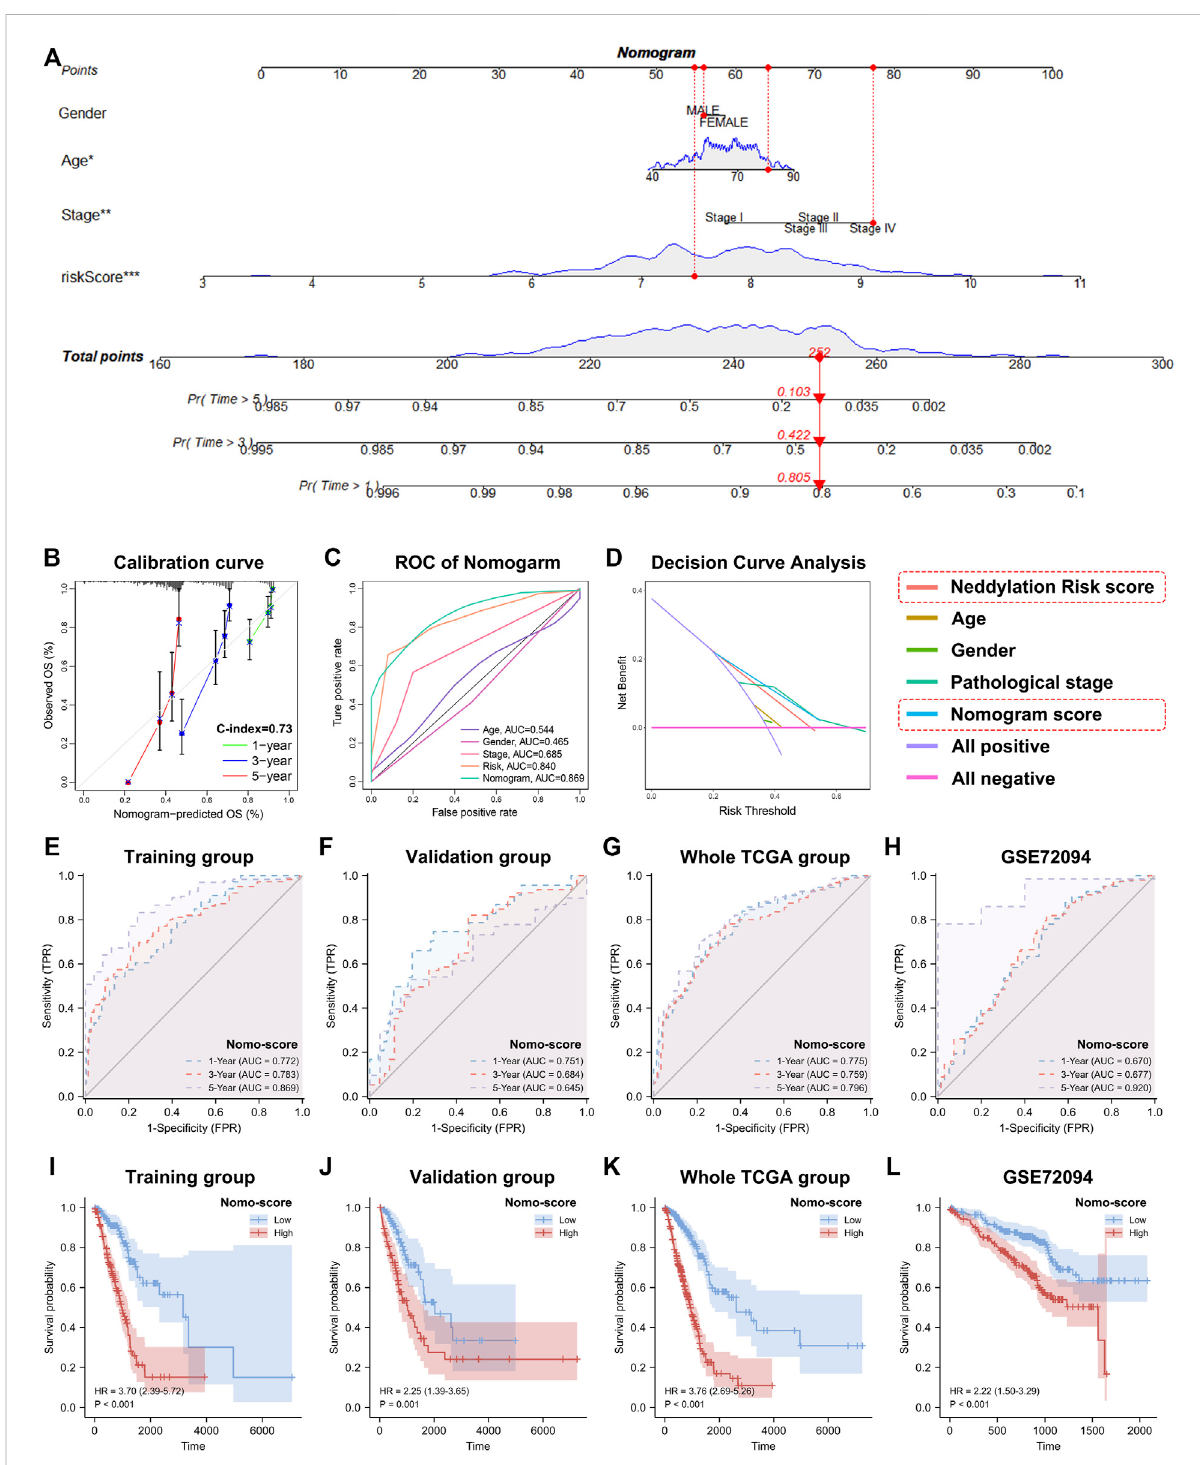
FIGURE 8 Construction of nomogram based on risk score and clinical factors. (A) A more predictive nomogram. (B) Calibration curve of 1-year, 3-year, and 5-year survival time. (C) Nomogram ’ s 5-year survival time ROC curve. (D) Nomogram ’ s 5-year survival time DCA curve. (E – H) Time-dependent ROCcurvesofthetrainingset,validationset,entireTCGAset,andGSE72094(basedonnomo-score). (I – L) Kaplan-Meieranalysesofthetrainingset, validation set, entire TCGA set, and GSE72094 (based on